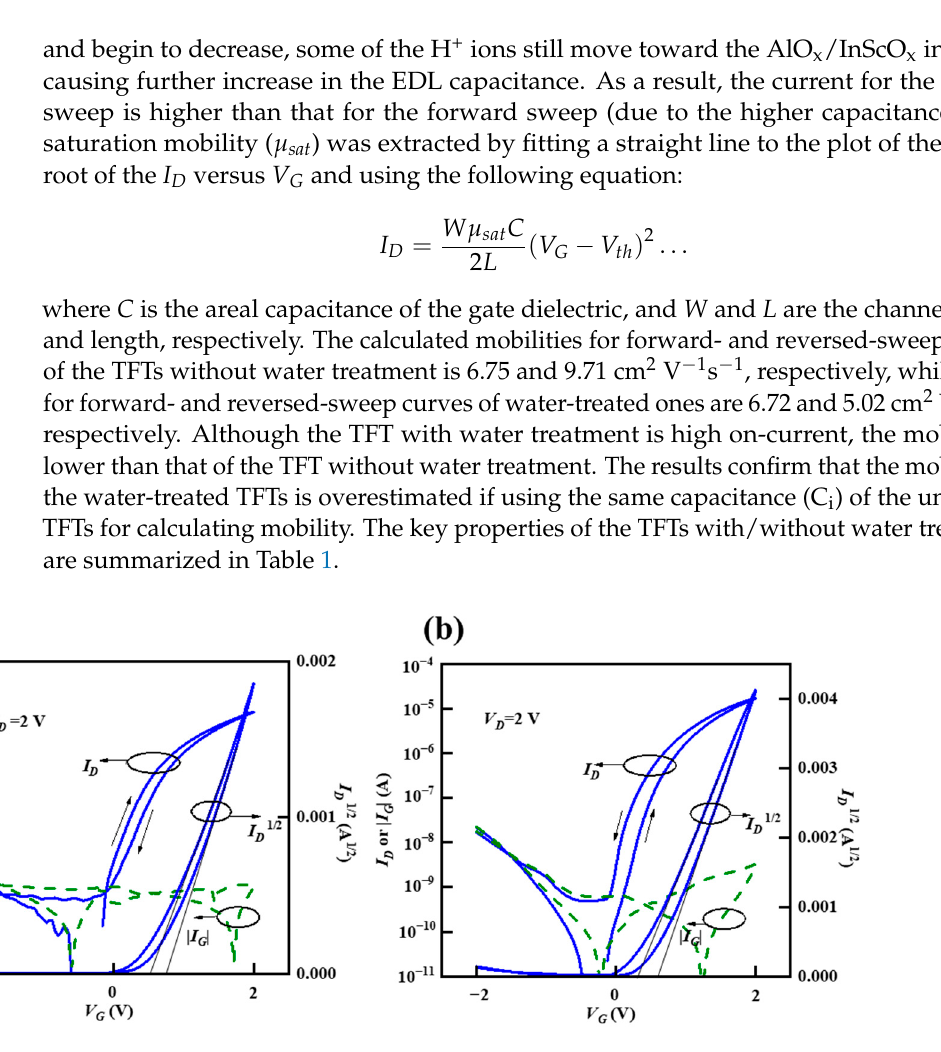
Figure 5. Transfer curves for InScO x TFTs with AlO x gate dielectrics ( a ) without and ( b ) with water treatment; the AlO x gate dielectrics were annealed at 350 °C for 1 h. Table 1. Electrical properties of the InScO x /AlO x TFTs with or without water treatment .